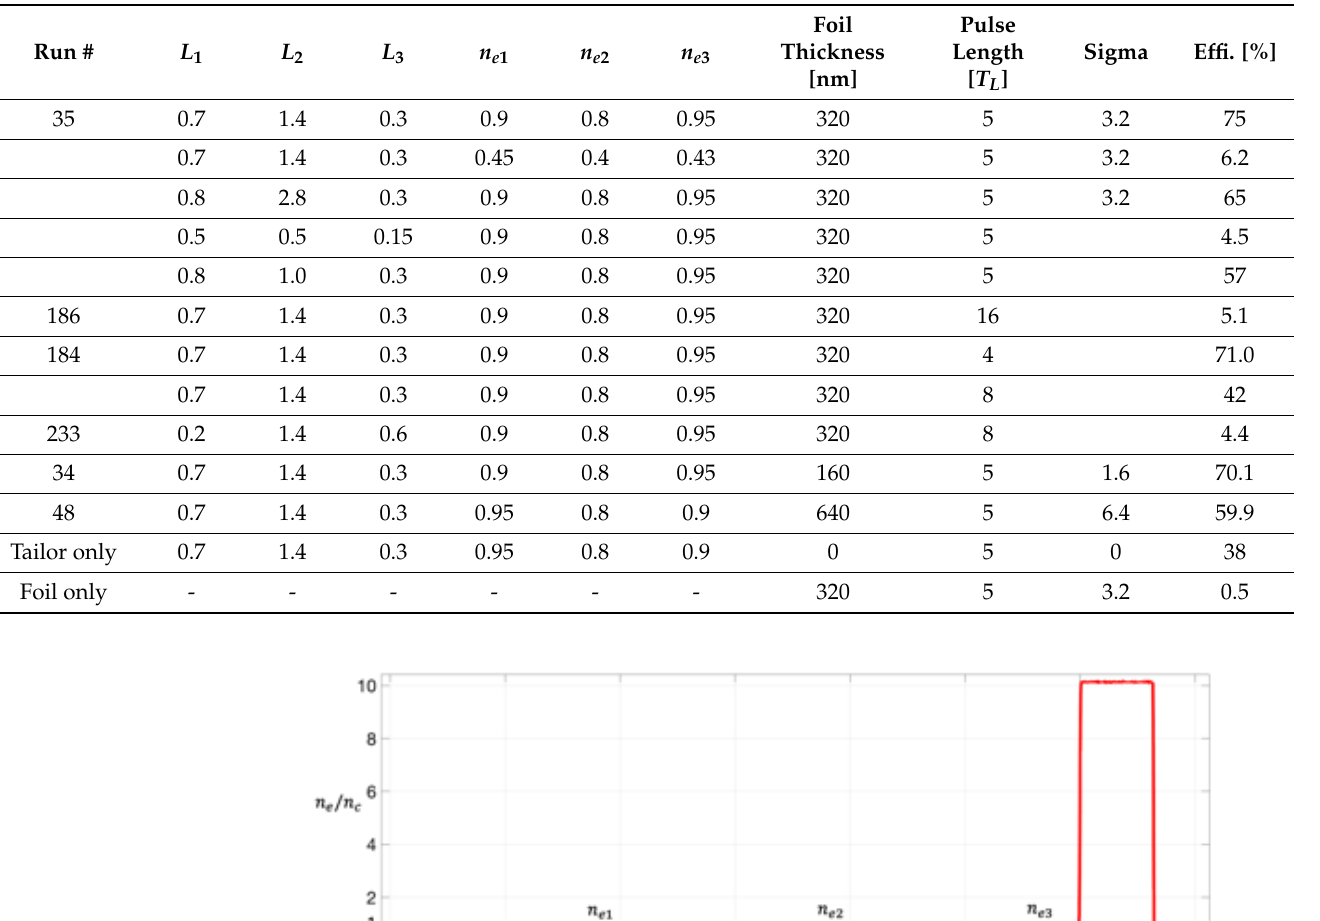
Table 1. Summary of the most successful runs based on laser-to-proton energy efficiency conversion. Parameter varied are in columns 2–8 are shown in Figure 1. The last two rows display the extreme cases of tailor region only and foil-only.